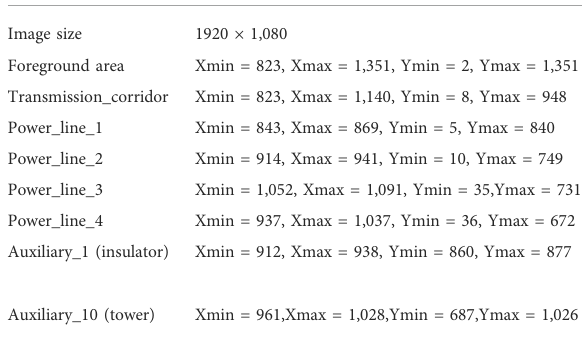
TABLE 3 Model ’ s output.